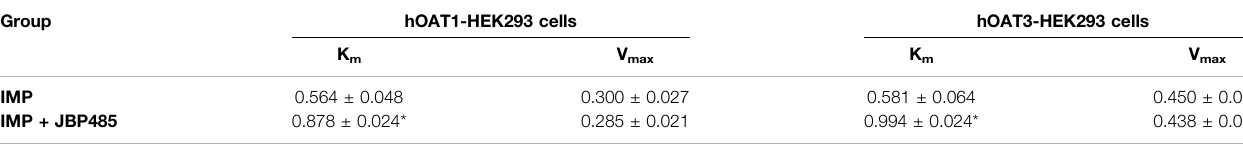
TABLE 3 | K m and V max values of IMP with or without JBP485 in hOAT1-HEK293 cells and hOAT3-HEK293 cells. Group